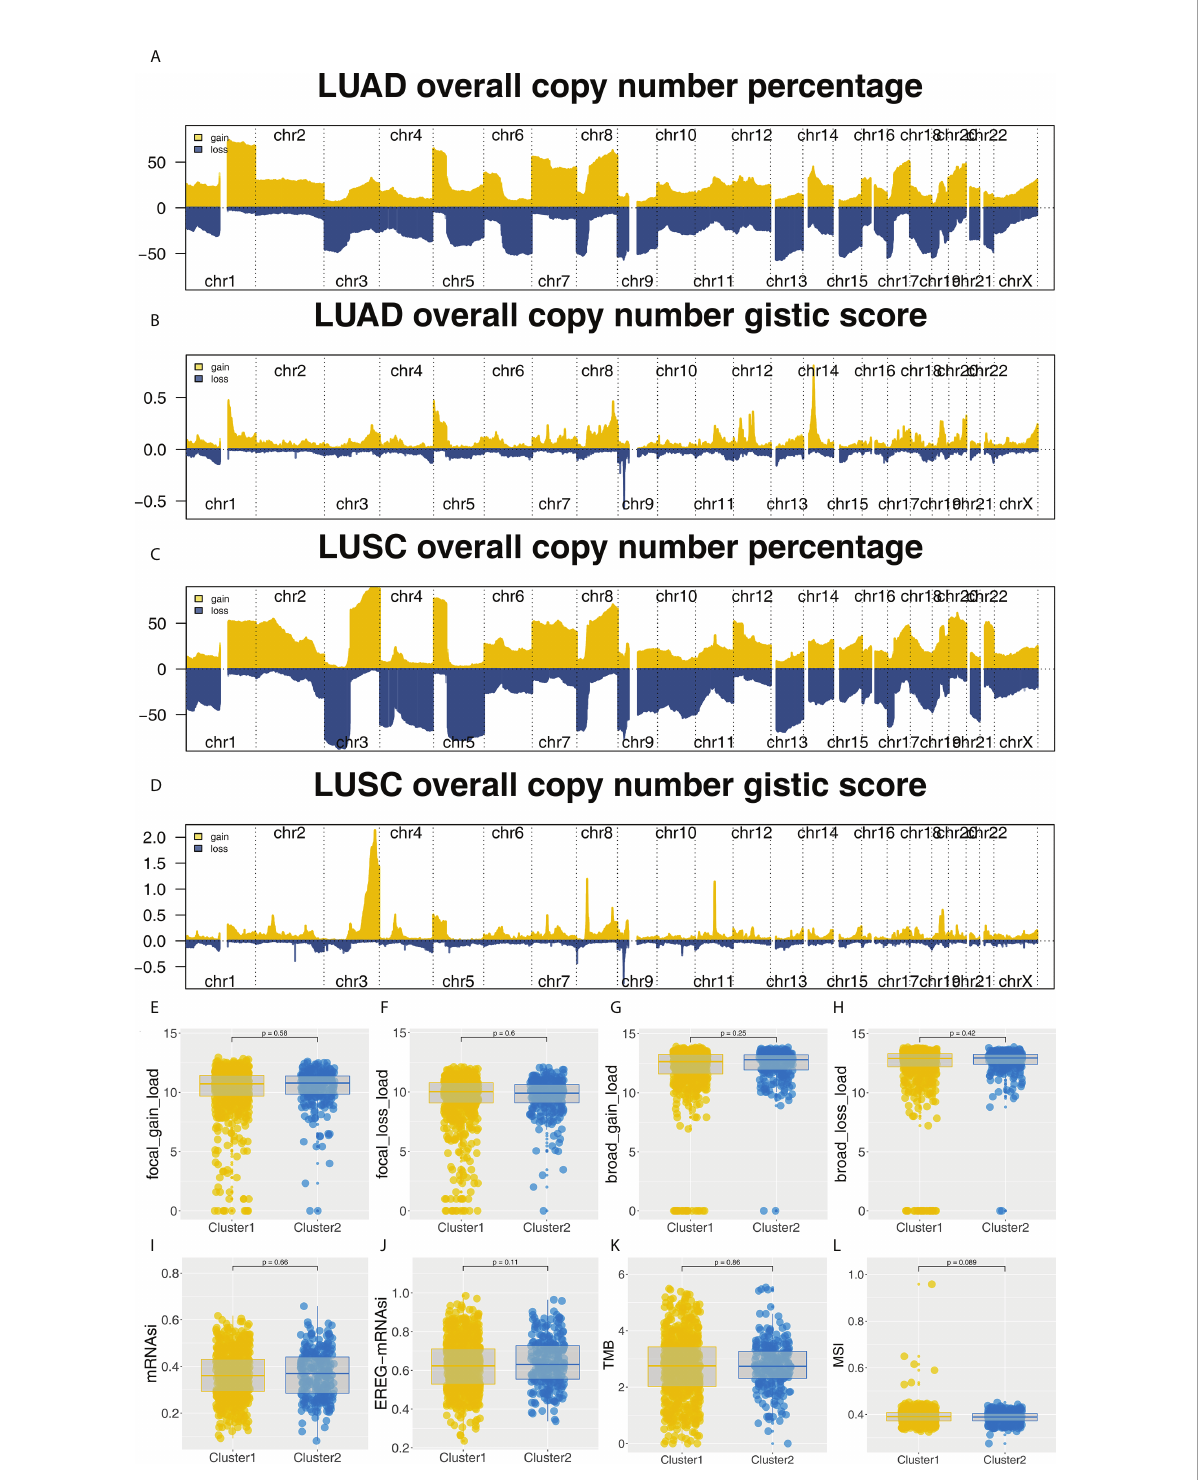
FIGURE 6 Genomic analysis. (A-D) The copy number percentage and gistic score of TCGA-NSCLC in Cluster1 and Cluster2; (E-H) The CNV burden difference in focal gain load, focal loss load, broad gain load and broad loss load level; (I-L) The difference of TMB, MSI, mRNAsi and EREG- mRNAsi in Cluster1 and Cluster2